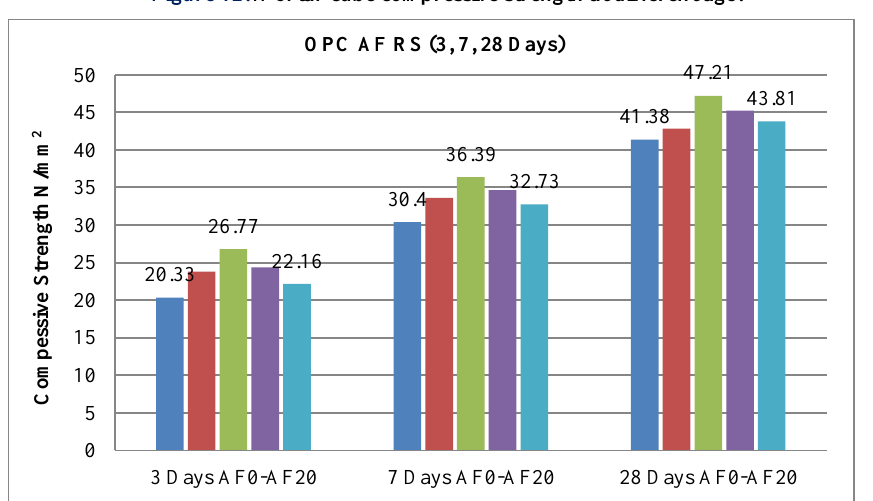
Figure 13. Mortar cube comparative compressive strength at the age of 3, 7, 28